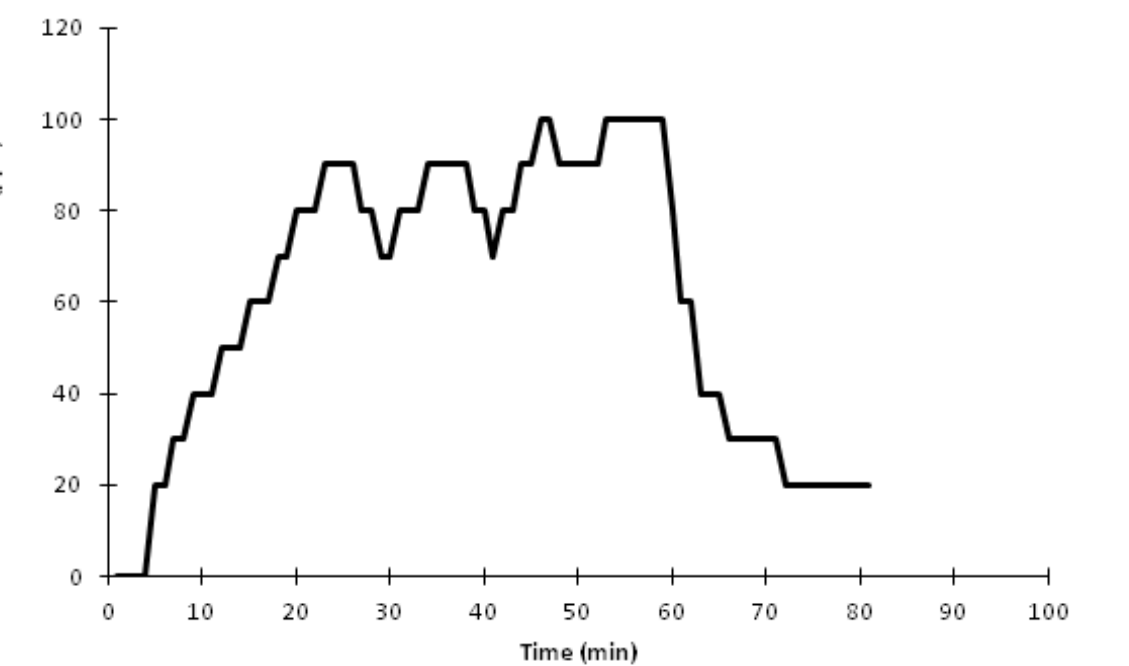
Figure 2. Ozone concentrations inside the empty dryer with a 5 mg/h ozone generator. Outside ozone was undetectable (<10 ppb) under this experimental setup.